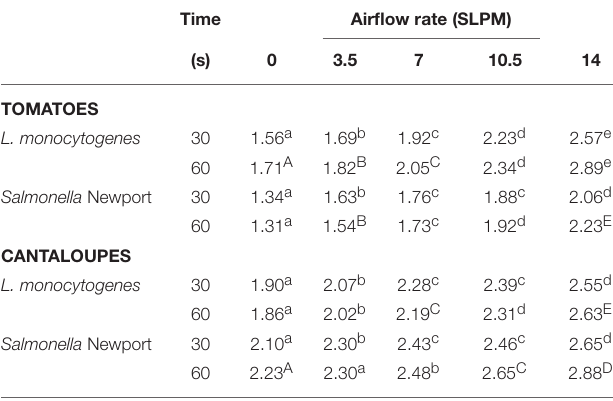
Frontiers in Sustainable Food Systems |